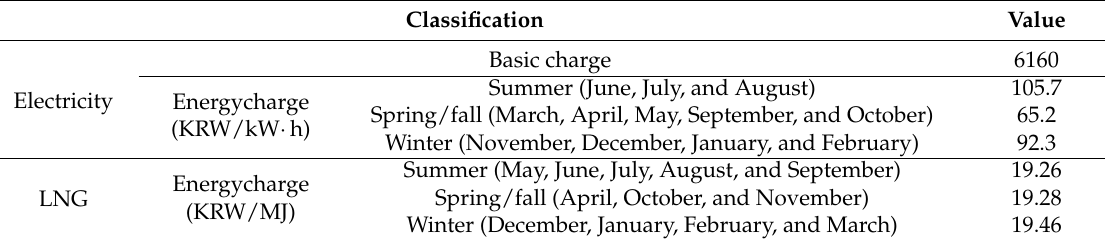
Table 2. Electricity and liquid natural gas(LNG)